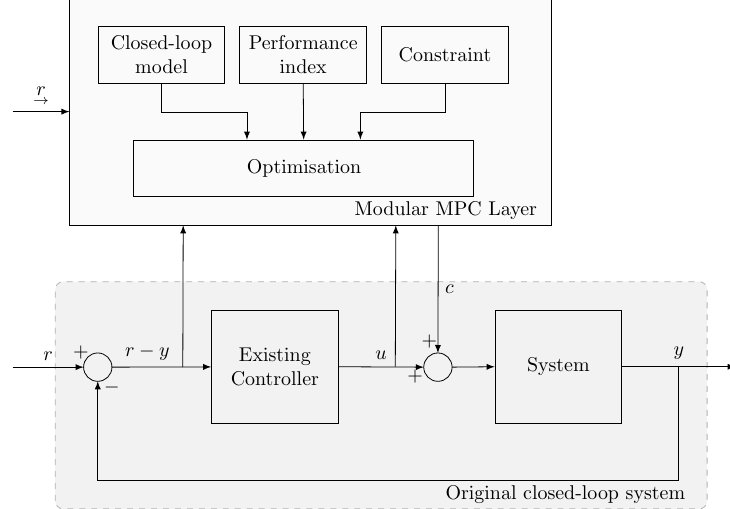
Figure 1. Schematic of modular model predictive control layer on top of an existing feedback